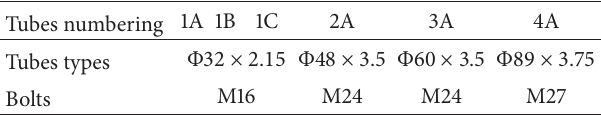
Table 1: Tube types and specifications